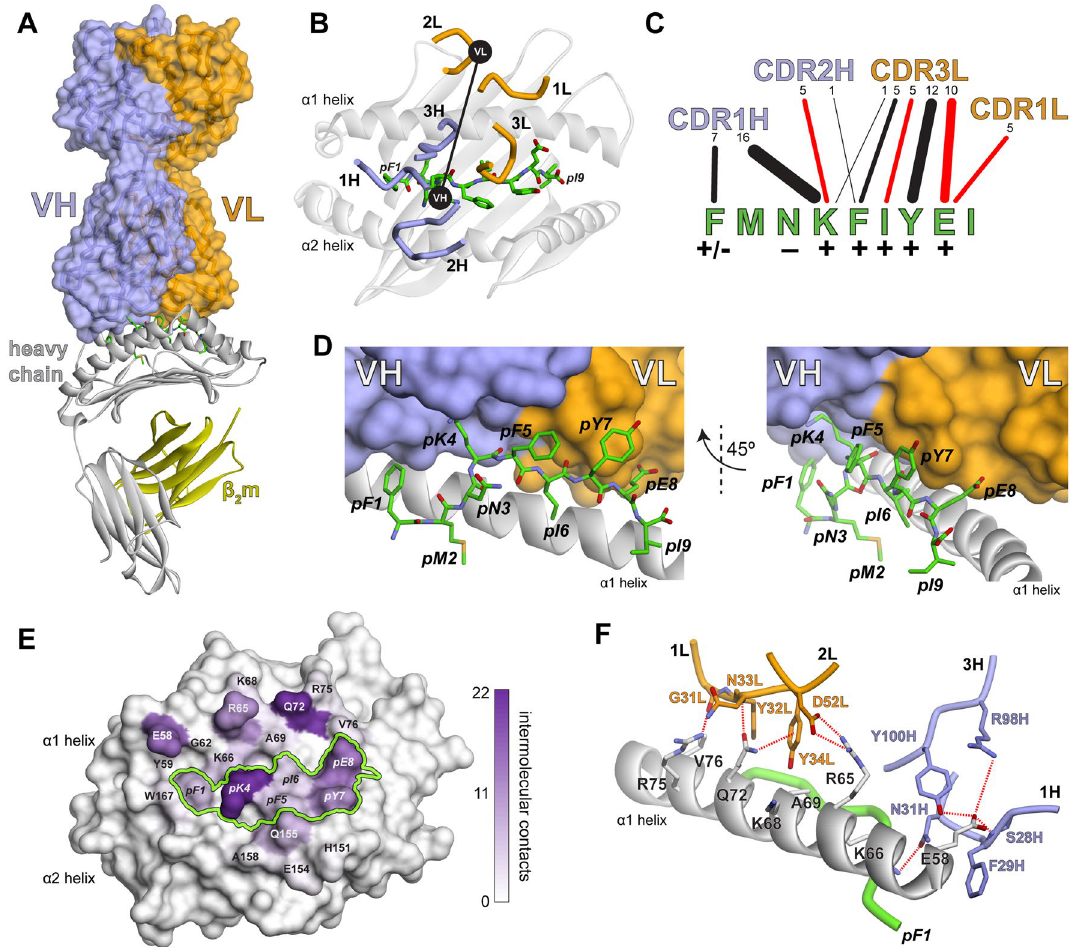
Figure 2. The TCRm binds centrally over the AFP/HLA-A*02 complex engaging the full length of the AFP peptide. ( A ) Overview of the TCRm-AFP/HLA-A*02 complex with the heavy and light chains of the TCRm, the HLA-A*02 heavy chain, peptide, and β 2 -microglobulin colored as indicated. This color scheme is maintained throughout the figure. ( B ) The TCRm and its CDR loops are positioned centrally over AFP/HLA-A*02, forming a diagonal binding mode mimicking that formed by naturally occurring αβ TCRs. The CDR loops are indicated, and black circles indicate the centers of mass of the VH and VL domains. ( C ) TCRm contacts to the peptide are formed by CDR1H, CDR2H, CDR3L, and CDR1L. Contacts from each loop to each peptide amino acid are indicated by lines. The number of contacts is shown by the numbers across the top and represented by line width. Red lines indicate the presence of one or more hydrogen bond or salt bridge. The impact of alanine substitutions at the various peptide positions on TCRm recognition, taken from Ref. 13 , is indicated by the symbols underneath the peptide amino acids. ( D ) Illustration of how the TCRm packs against the peptide, reflecting engagement across the peptide length. ( E ) TCRm contacts to AFP/HLA-A*02 mapped to the surface of the molecule. The number of contacts to each amino acid is indicated by purple-white color scale. The peptide surface is outlined by the green line. Substantially more contacts are made to the HLA-A*02 α1 helix compared to the α2 helix. ( F ) The TCRm interacts with the HLA-A*02 α1 helix via a series of interdigitating side chains that form multiple electrostatic interactions with polymorphic sites as indicated by the dashed red